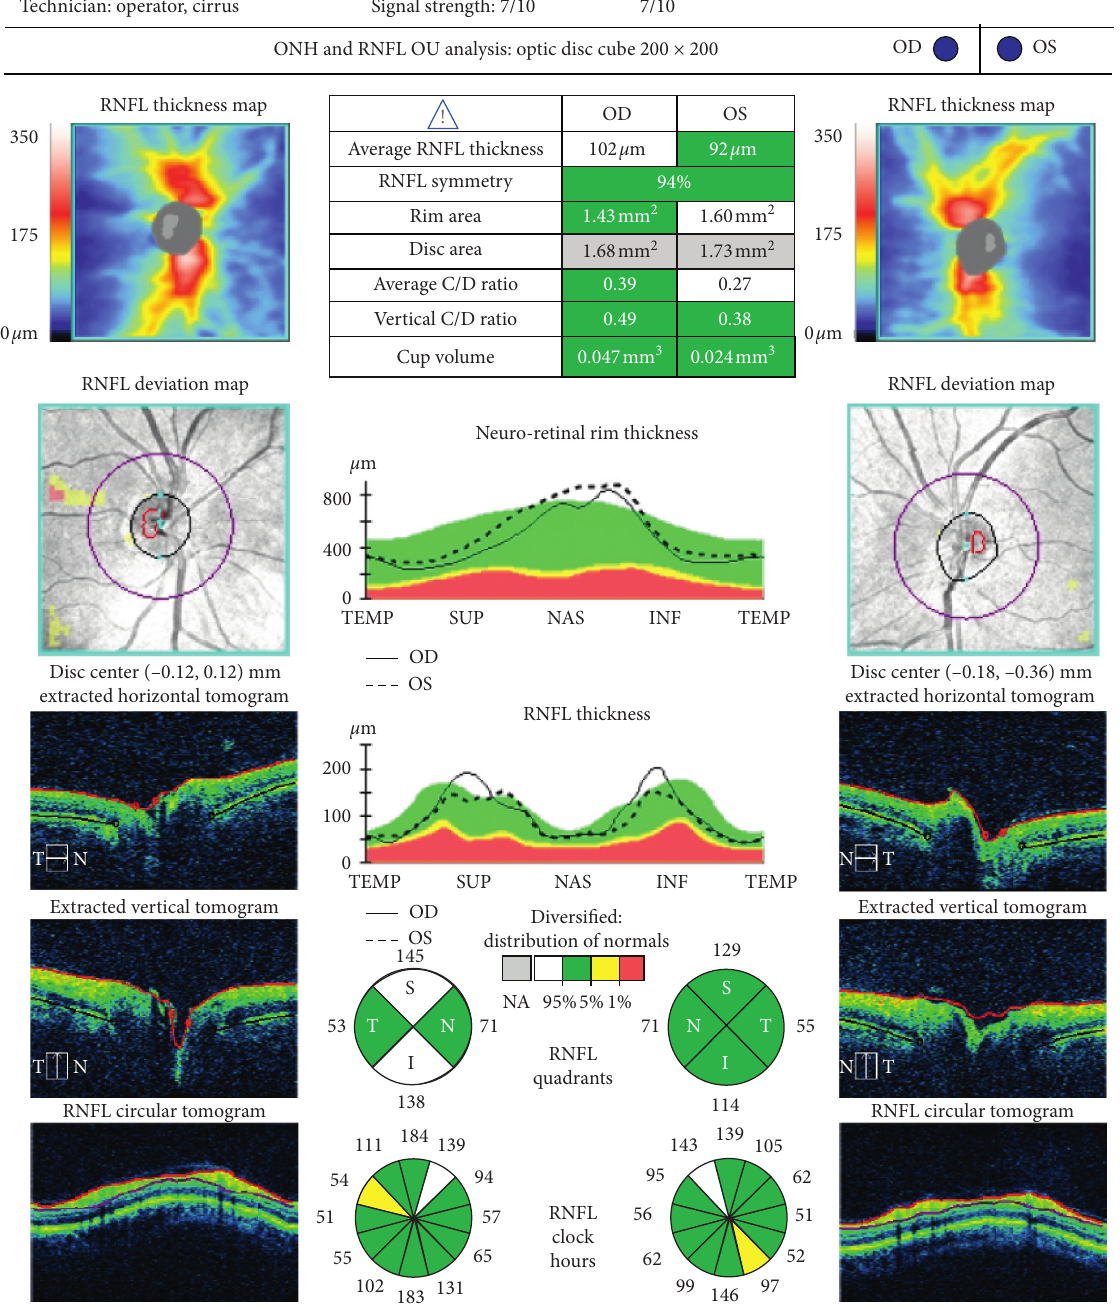
Figure 4: Postoperative retinal nerve fiber layer (RNFL) analysis of the same patient shown in Figure